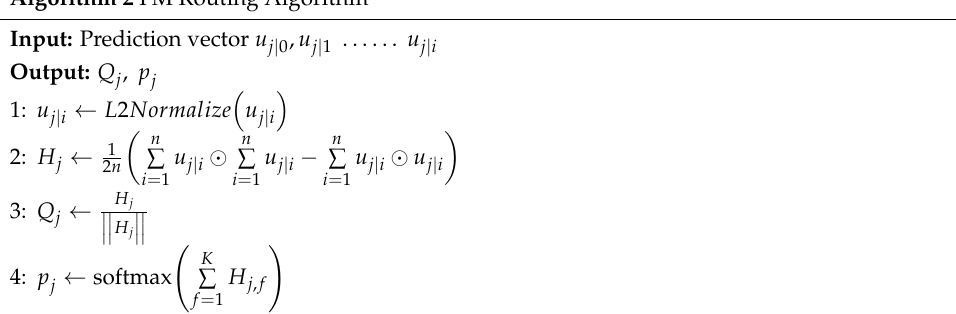
Algorithm 2 FM Routing